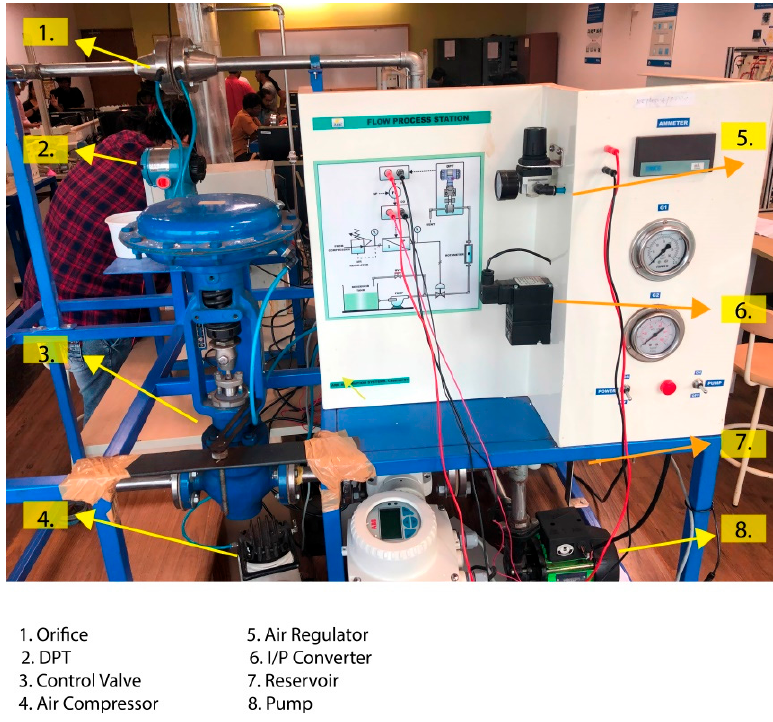
Figure 1. Experimental Setup.